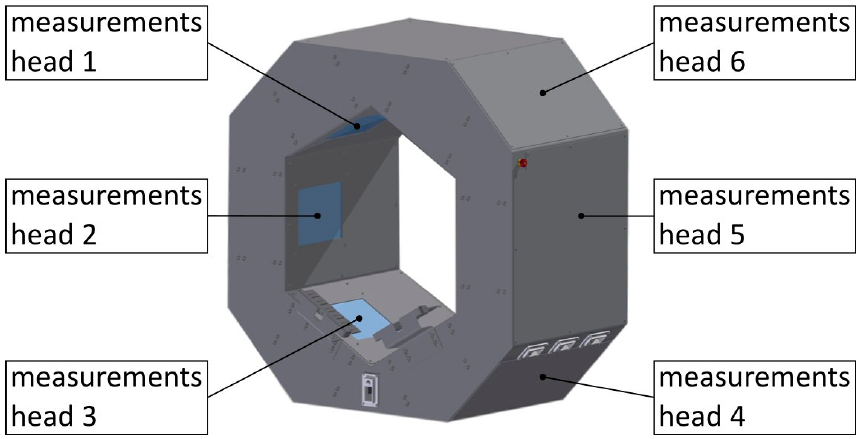
Figure 5. 3D model of the laser triangulation scanner with measuring heads marked.